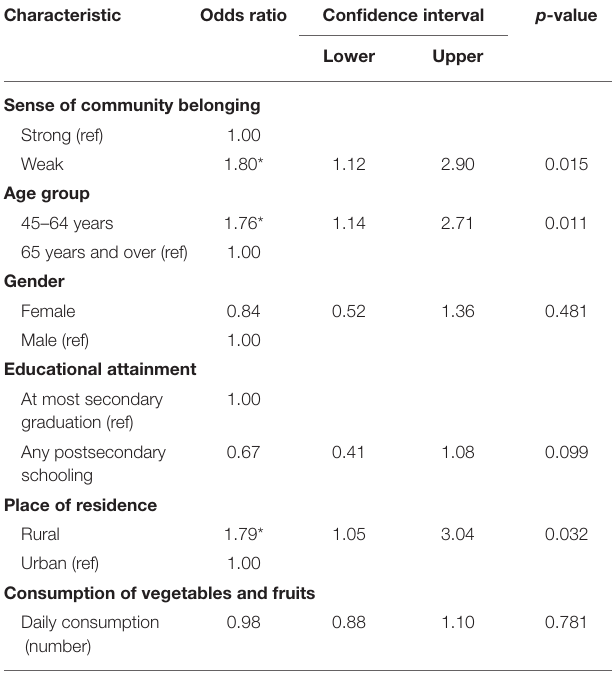
TABLE 1 | Adjusted odds ratios and 95% confidence intervals from the multiple logistic regression for the risk of diabetes hospitalization. Characteristic Odds